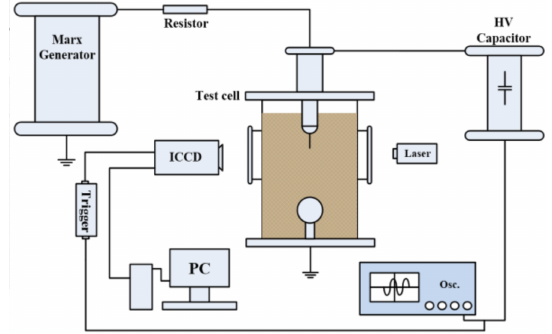
Figure 2. Schematic of experimental setup for measurement of breakdown strength and prebreakdown streamers.